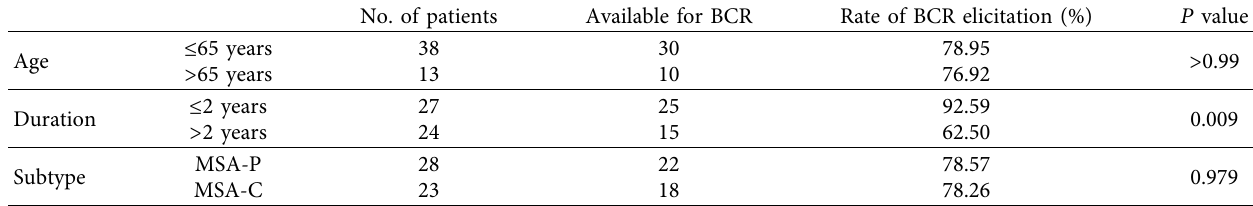
Table 5: Comparison of the elicitation rates of BCR in each MSA subgroup.